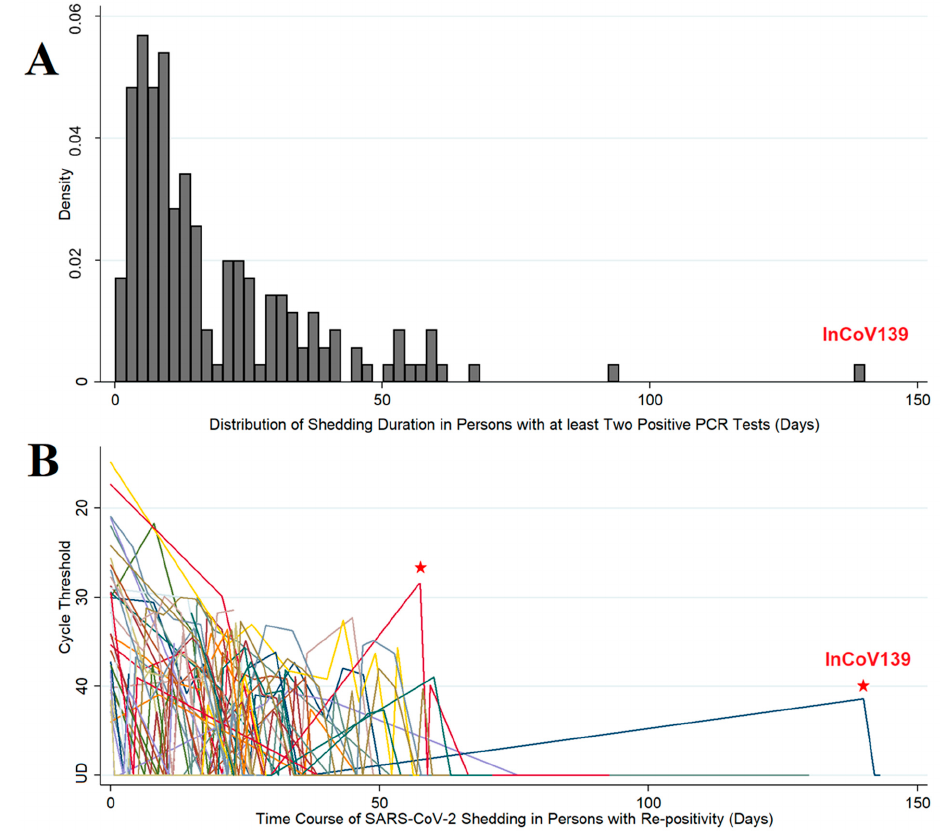
Figure 1. Population viral RNA shedding from patients with COVID-19. Panel ( A ): Distribution of shedding duration in patients who had at least 2 positive SARS-CoV-2 PCR tests. The shedding duration was calculated as the time from first positive sample to last positive sample. In the histogram (n = 176), the proportion of patients is plotted as density on the y -axis and shedding duration (in days) is on the x -axis. Panel ( B ): Time course of SARS-CoV-2 shedding in patients (n = 43) who had “re-positive” pattern (repeat SARS-CoV-2 PCR positive after negative testing in patients with initially PCR-confirmed COVID-19, i.e., a positive-negative-positive pattern). In the spaghetti plot, semi-quantitative real-time PCR expressed in cycle thresholds (Ct) is plotted on the y -axis and time course in days from first positive to last positive is on the x -axis. Ct is the average result of E & N2 genes except where one target was undetectable and then Ct was set to value of single positive target. Ct range: 14.9–44.0. Negative (undetectable) results are set to Ct = 50 for purposes of display. UD = undetectable. Red stars mark possible reinfections due to low CT value at re-positive, or long duration since last positive PCR,